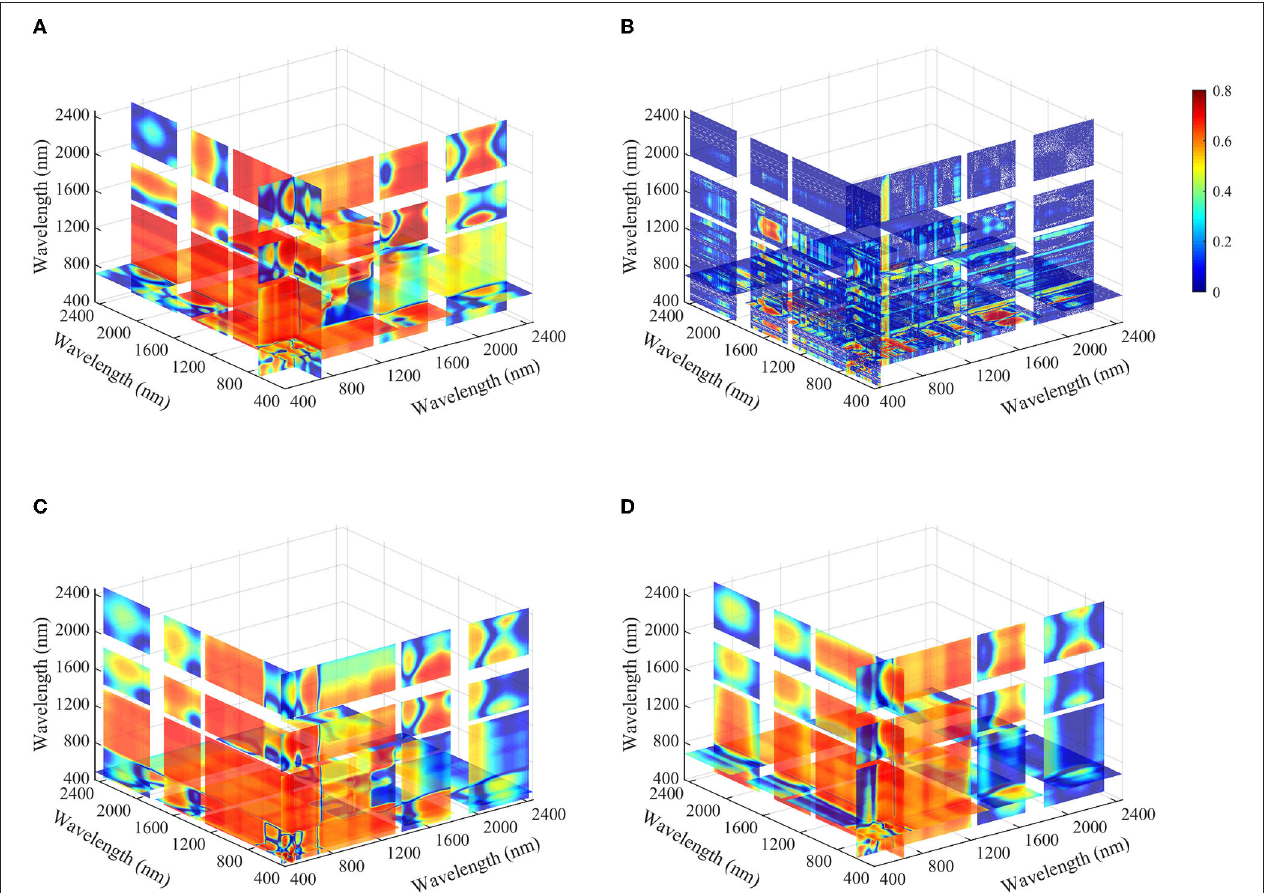
FIGURE 7 | Coefficient of determination ( R 2 ) between leaf nitrogen accumulation and the optimal three-band spectral indices based on different transformation methods (A) OR-TBI2 (700, 685, 709), (B) FDR-TBI1 (451, 706, 688), (C) CR-TBI2 (472, 445, 484), and (D) Log(1/R)-TBI2 (643, 598, 676) ( n = 160).